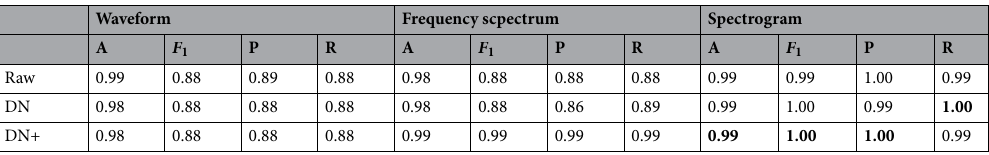
Table 4. Performance of the proposed denoising autoencoder model in distinguishing RBC and PNT1A cells. Raw, DN, and DN+ indicate the case without using any denoising method, the case only using denoising autoencoder, and the case using denoising autoencoder and injecting the Gaussian noise, respectively. Significant values are in [bold].